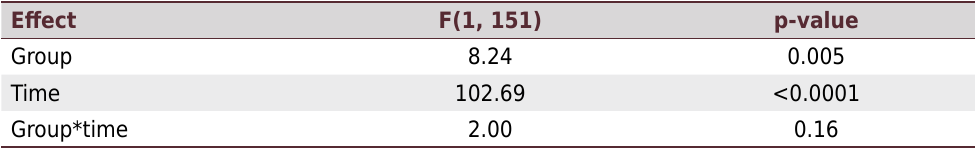
Table 5. Two-way analysis of variance (ANOVA) for soil knowledge. Confidential code was not considered in this analysis. n = 155; one student did not fill in knowledge responses in pre-and